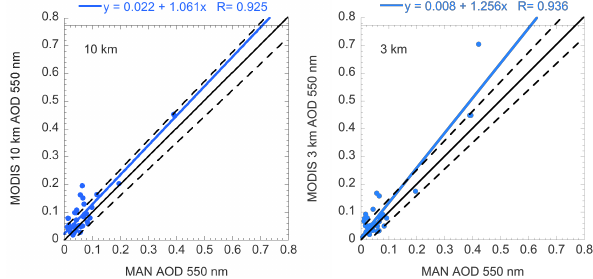
Fig. 14. Scatter plot of MODIS 10km and 3km retrievals of AOD at 550nm plotted against collocated data from the Maritime Aerosol Network (MAN). At 10km and 3km, 41 and 40 collocations were identified, respectively, in the 6 months undergoing